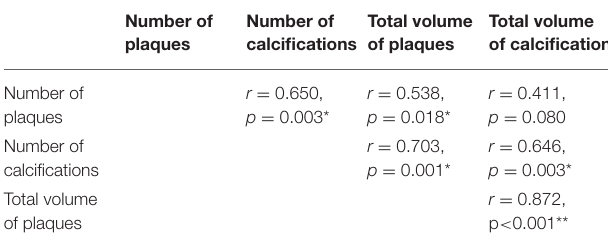
TABLE 3 | Linear regression results of case-based